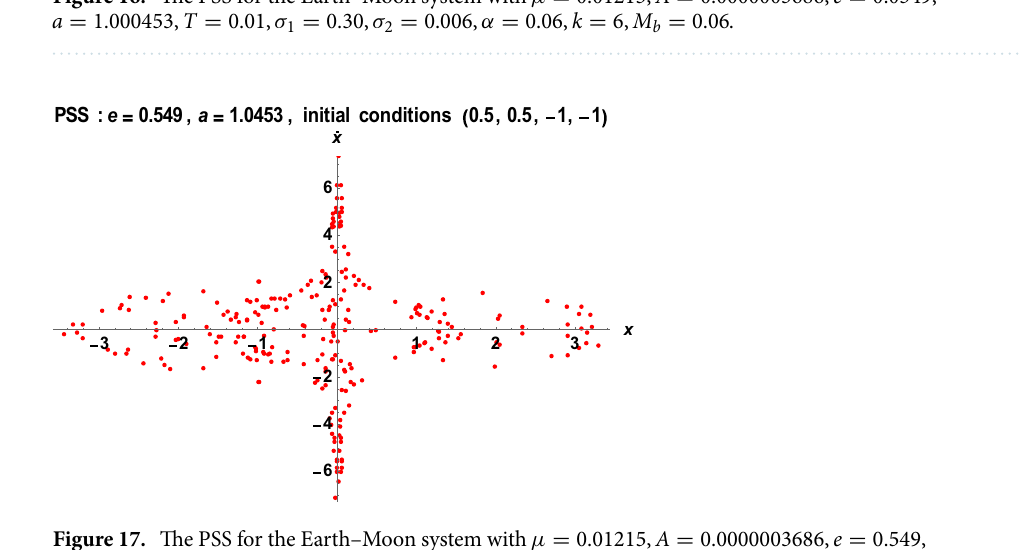
Figure 17. The PSS for the Earth–Moon system with µ = 0.01215, A = 0.0000003686, e = 0.549, a = 1.0453, T = 0.01, σ 1 = 0.30, σ 2 = 0.006, α = 0.06, k = 6, M b = 0.06